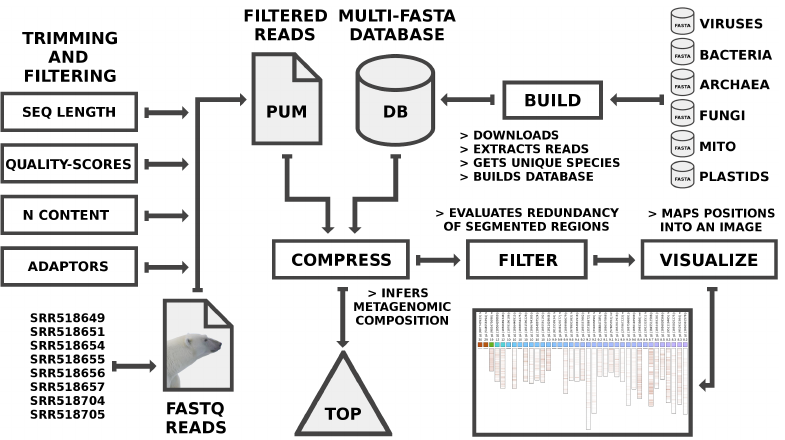
Figure 1. Pipeline for the analysis of metagenomic composition using the ancient sample (PUM) and a database containing several reference organisms as input, where MITO stands for mitochondrial genomes. The BUILD phase was conducted according to Section 2.2. The COMPRESS phase is conducted using the computation of FALCON-meta. The FILTER phase was a control to detect self-redundancy and